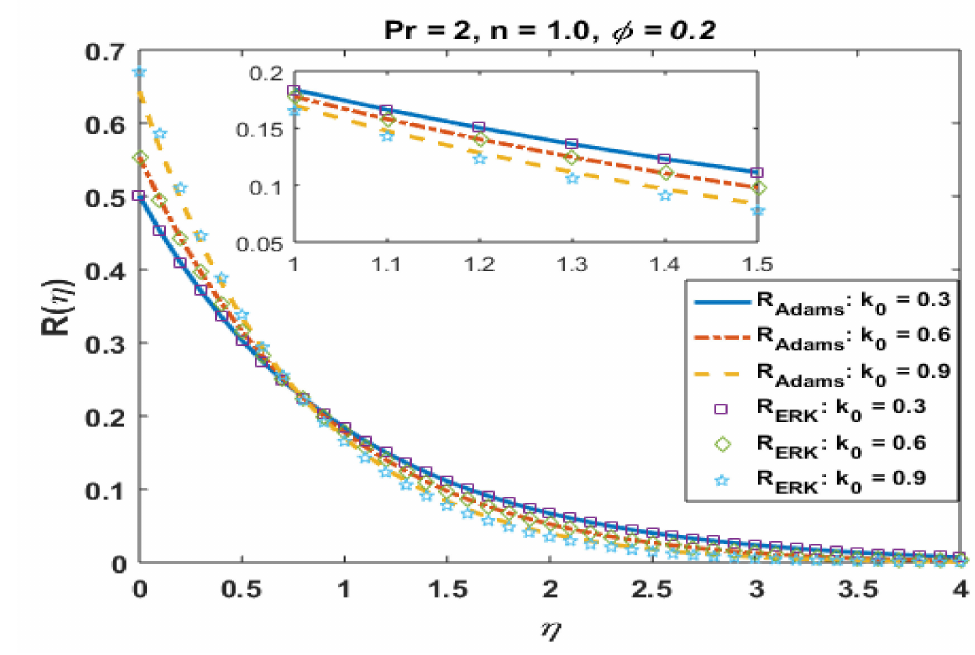
Figure 16. Effects of k 0 on R ( η ) .